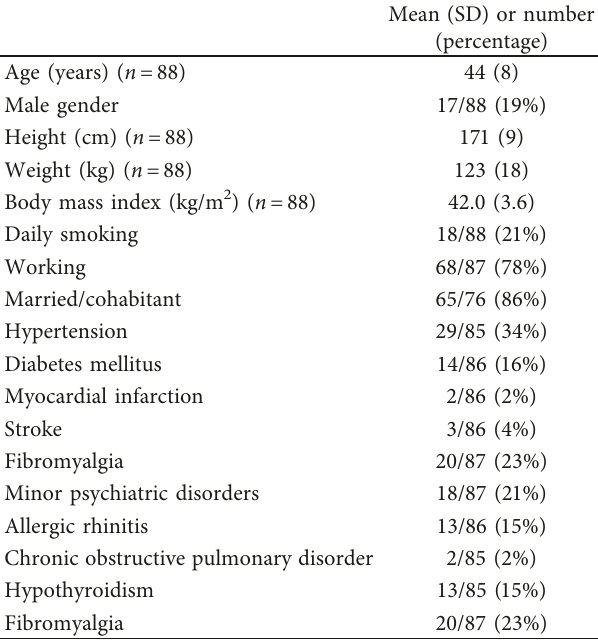
Table 1: Characteristics of the included subjects.